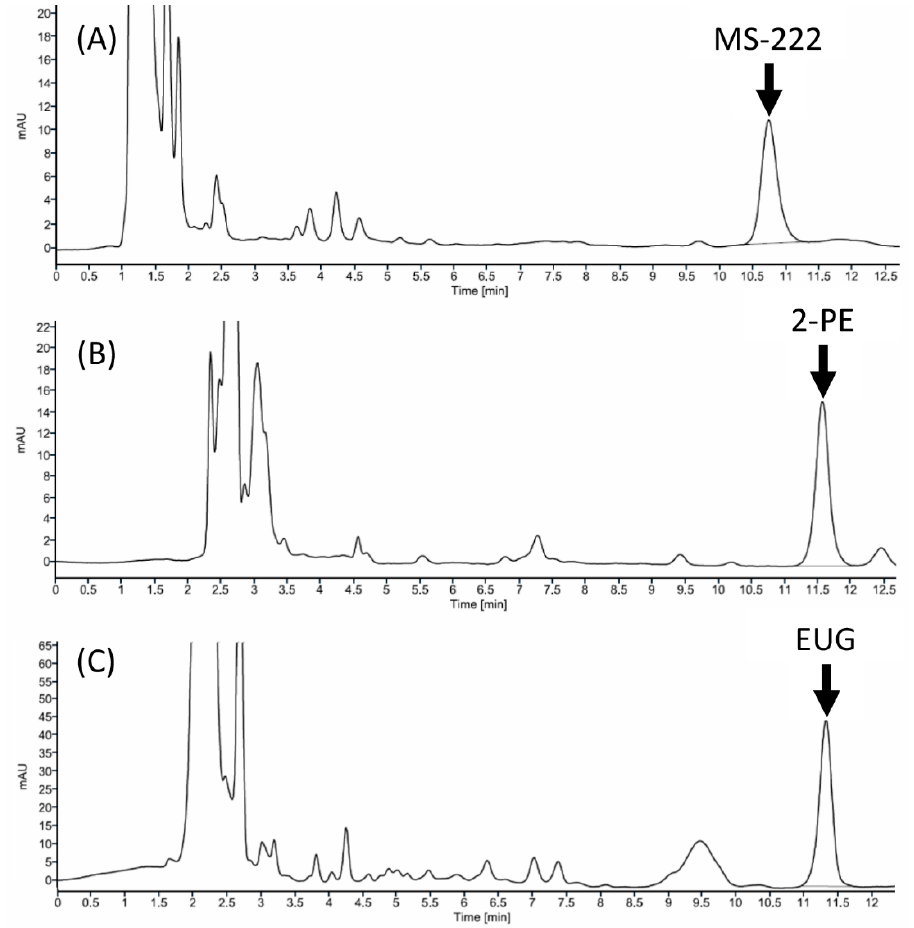
Figure 1. The representative chromatograms of 1 µ g/mL reference standard of anesthetics in tilapia serum. The mobile phases consisted of acetonitrile, methanol, and the phosphate buffer (10 mM NaH2PO4-Na2HPO4, pH 5) at a ratio of: ( A ) 30:0:70 v / v for MS-222 (UV 200 nm); ( B ) 17:17:66 v / v for 2-PE (UV 218 nm); ( C ) 45:0:55 v / v for EUG (UV 200 nm).